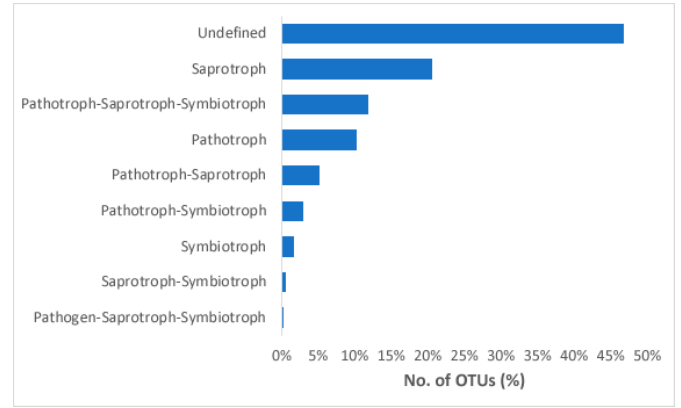
Figure 2. Relative abundance of fungi in seed assigned to different trophic levels in FUNGuild. Trophic modesinclude: pathogen[pathotroph], saprotroph, andmutualist[symbiotroph],